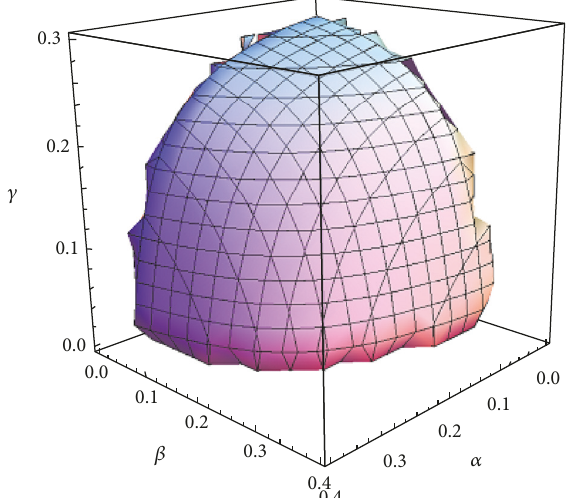
Figure 1: The stable region of Nash equilibrium point, (𝑒 1 , 𝑒 2 , 𝑒 3 ) = (0.9, 1.0, 1.1) .